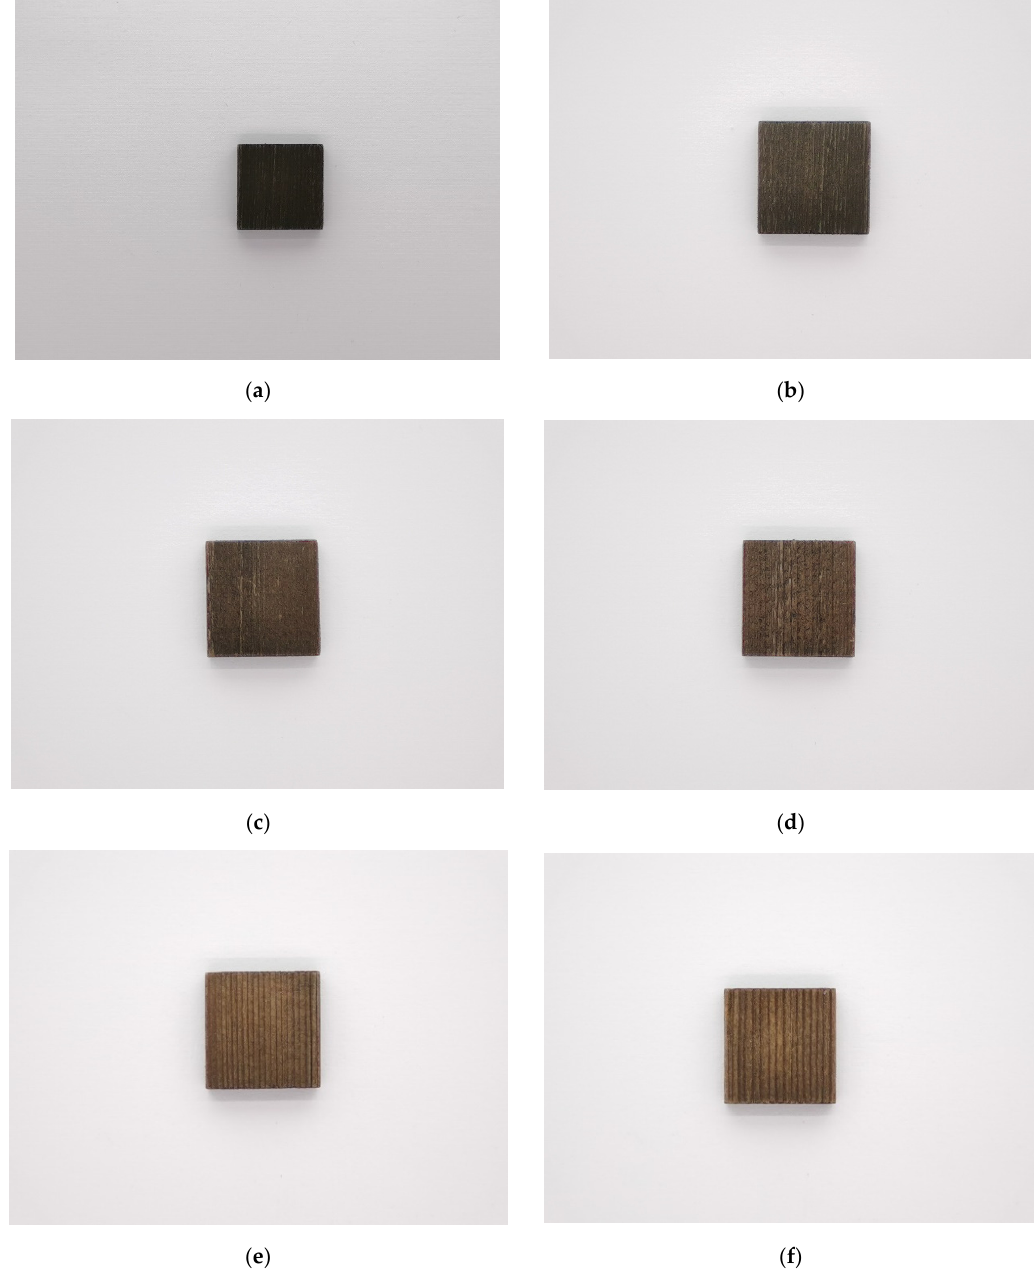
Figure 4. Images of the etched samples with di ff erent etching times: ( a ) Control; ( b ) etching for 5 min; ( c ) etching for 30 min; ( d ) etching for 1 h; ( e ) etching for 2 h; ( f ) etching for 5 h. Table 2. Chromaticity parameters of the etched samples with di ff erent etching